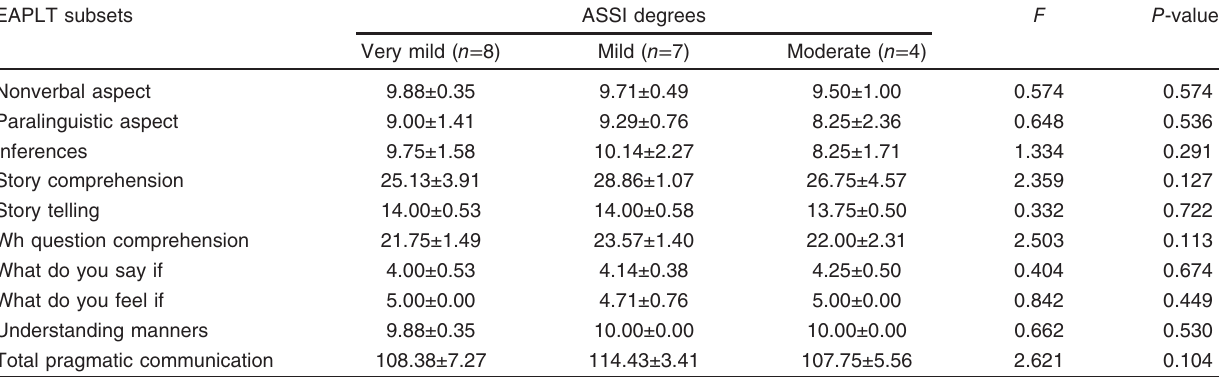
Table 12 Relation between stuttering severity measured by Stuttering Severity Instrument for Children and Adults − Arabic version, and pragmatic language development in children in age group II (6 years 1 month 1 day to 7 years 12 months 31 days) using independent sample analysis of variance test